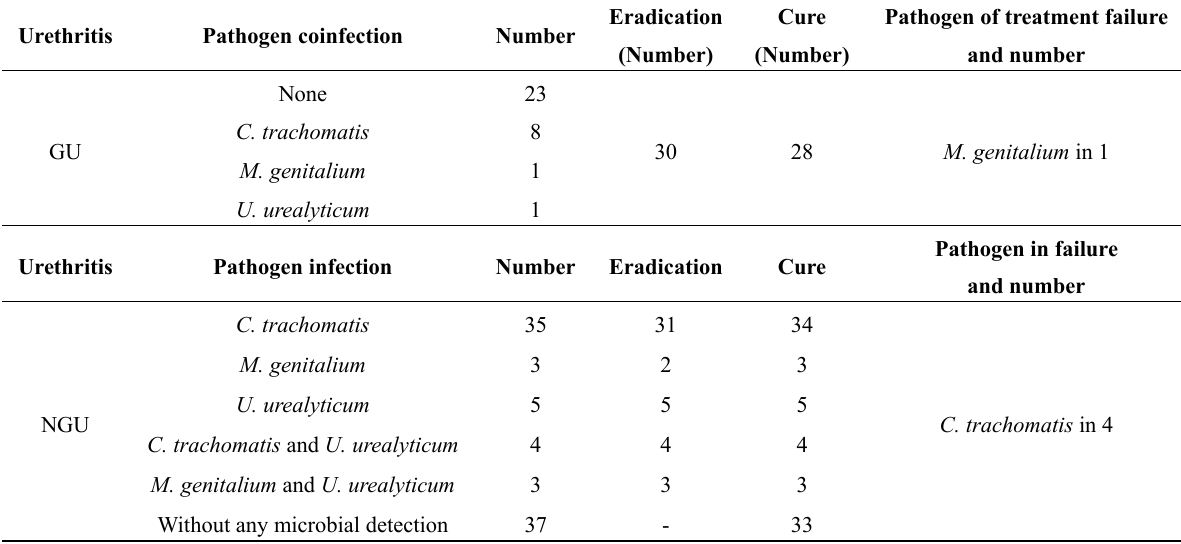
Table 3. Microbiological and clinical outcomes in patients with gonococcal urethritis (GU) and nongonococcal urethritis